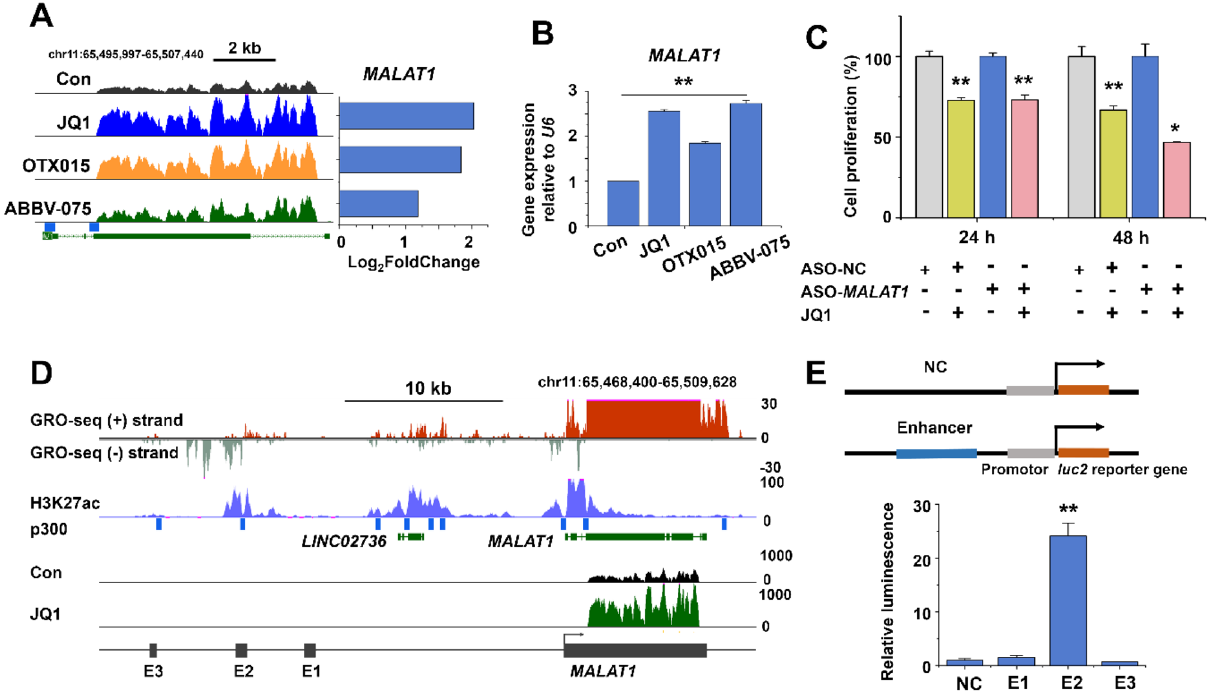
Figure 2. MALAT1 expression and putative MALAT1 enhancers in JQ1-treated HepG2 cells. ( A ) RNA-seq read densities (left) and corresponding log 2 fold changes (right) of the MALAT1 gene transcripts in BET inhibitor-treated vs. control HepG2 cells. ( B ) qRT-PCR analysis of MALAT1 levels. The data represent three independent experiments. The values are mean ± SD of triplicate wells. ** p < 0.01. ( C ) Cell proliferation was determined using WST-1 assay in MALAT1 ASO- and/or JQ1-treated HepG2 cells. The data represent three biologically independent experiments. * p < 0.05 and ** p < 0.01. ( D ) USCS genome browser view of the GRO- seq peaks, H3K27ac enrichment, p300 binding sites, and BRD4 binding sites along the MALAT1 locus (chr11: 65,468,400–65,509,628). The potential MALAT1 enhancer regions E1, E2, and E3 upstream of the MALAT1 gene are denoted. MALAT1 expression from RNA-seq read densities is represented with black (untreated) and green (JQ1-treated) peaks. ( E ) Verification of putative MALAT1 enhancers by luciferase reporter gene assays. The data represent three independent experiments. ** p <